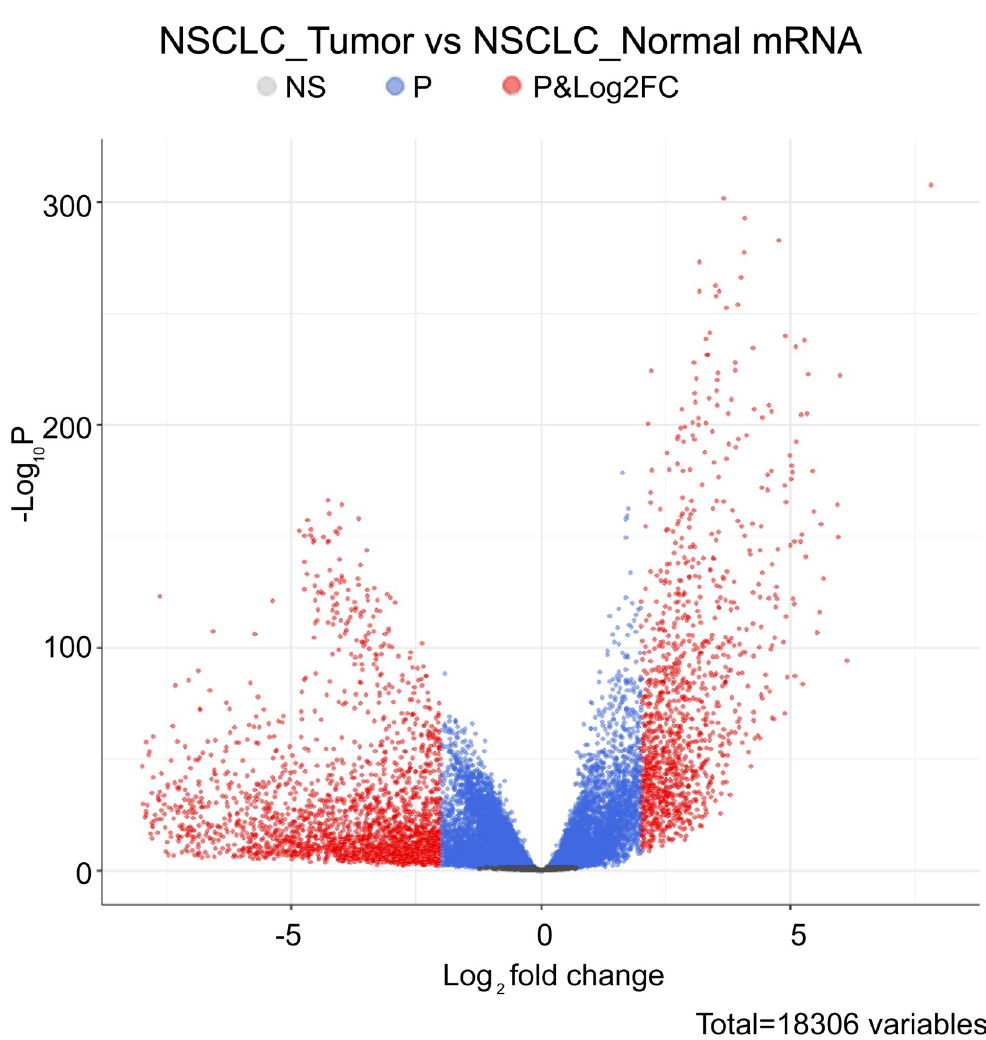
Fig 5. Differential expression of mRNA volcano in cancer tissues and adjacent tissues. The ordinate was p-value. The log2 value of the screening condition was used as the abscissa, p < 0.05. Red represents genes with fold change (FC) > 2 and P <